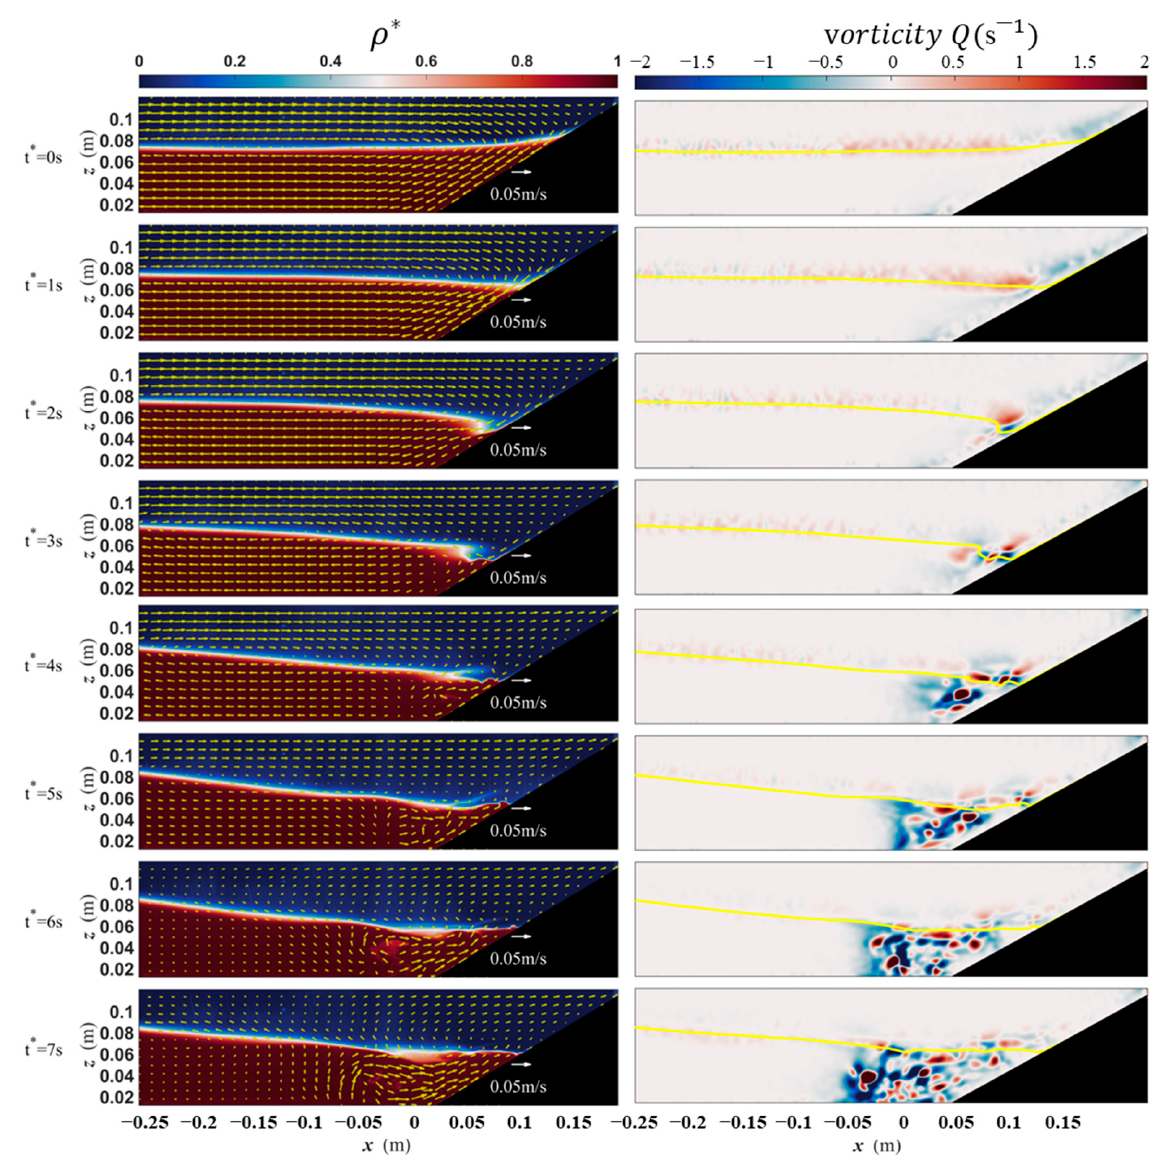
Figure 6. Density field and vorticity field of ISW evolution processes in Run 180-8.